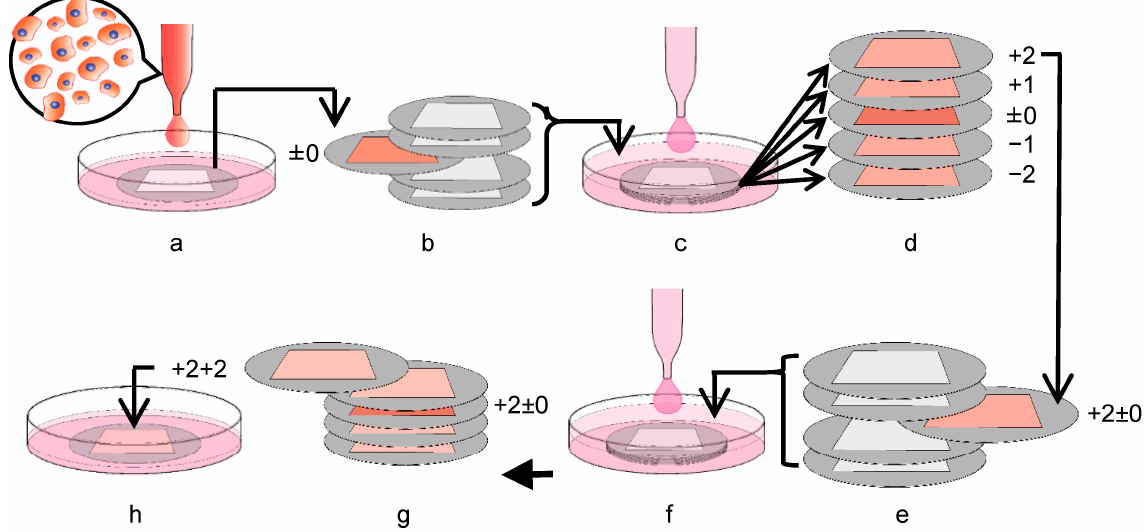
Figure 2. The scheme of multi-layered culture systems in the present study: ( a ) The C3H10T1/2 cells were seeded on a blank substrate and cultured for 24 h. ( b ) The substrate with C3H10T1/2 cells was transferred into the stacking assembly with 4 blank substrates without pressing. The membrane with seeded cells was defined as “ ± 0.” ( c ) The multi-layered 3D substrates, including layer “ ± 0,” were incubated for 10 days (first multi-layered culture). ( d ) In the first multi-layered culture, the upper layers were assigned positive numbers, whereas the lower layers were assigned negative numbers. ( e ) After the first multi-layered culture, each substrate moved into the other stacking assembly. This schematic shows that layer “+2” was used as a new cell source, defined as “+2 ± 0”. ( f ) The new stacking assembly was incubated for 10 days (second multi-layered culture). ( g ) The layers above “+2 ± 0” were assigned positive numbers (+2+1, +2+2), whereas the lower layers were assigned negative numbers (+2 − 1, +2 − 2). ( h ) After the second multi-layered culture, the substrates were isolated and cultured in a conventional culture